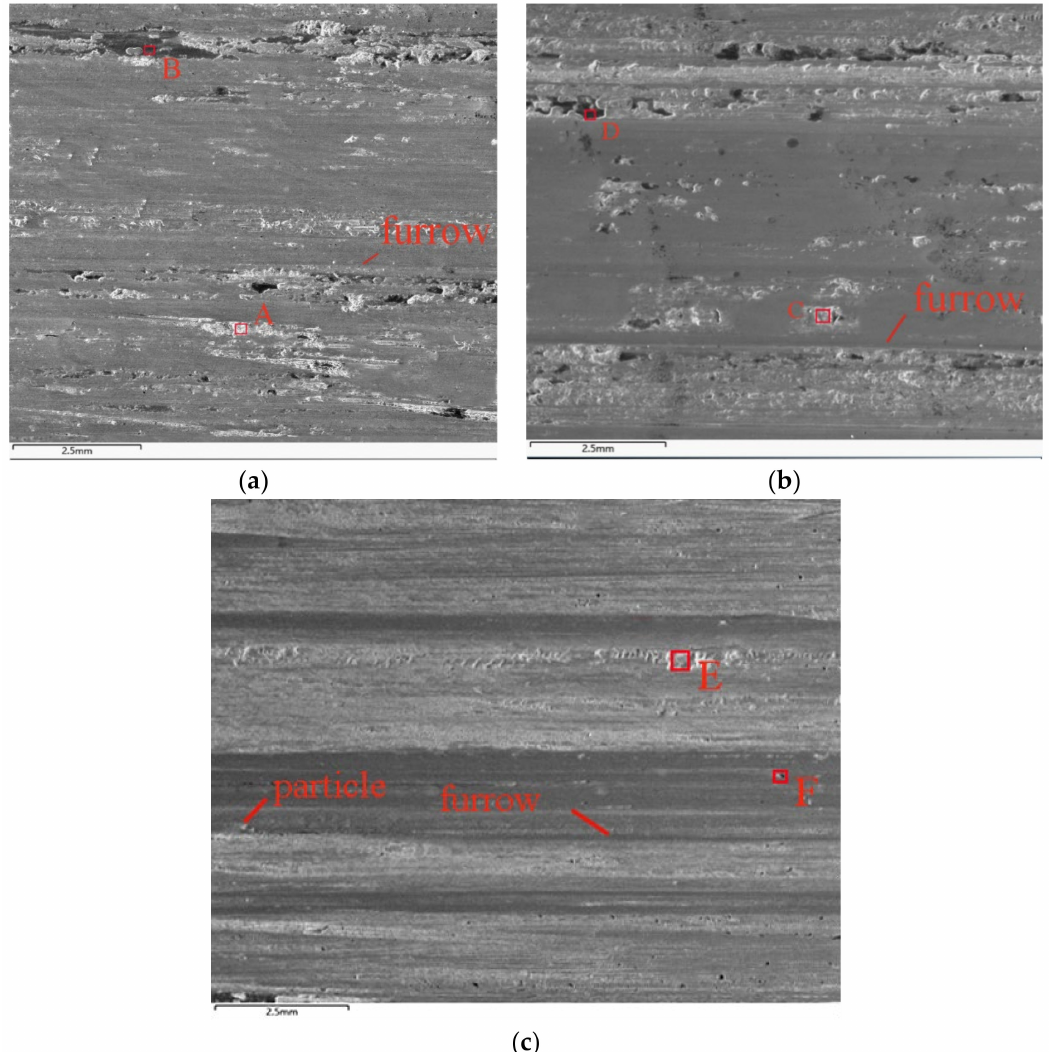
Figure 29. The wear surface morphology of hardened layer; ( a ) the wear surface morphology of hardened layer at movement speed of 300 mm/min, ( b ) the wear surface morphology of hardened layer at the movement speed of 400 mm/min, and ( c ) the wear surface morphology of hardened layer at the movement speed of 500